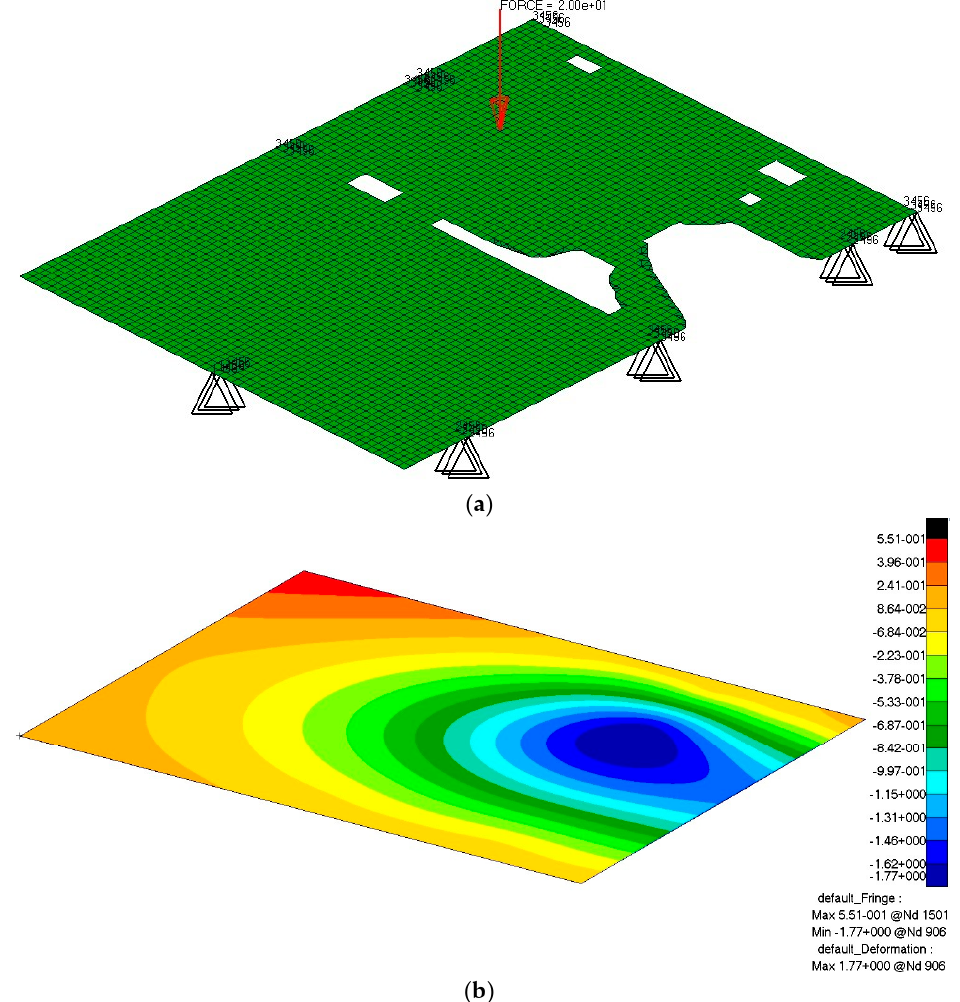
Figure 7. ( a ) Subcase 1: population reduction after topology optimization, ( b ) Subcase 1: optimum layout maximum deformation.